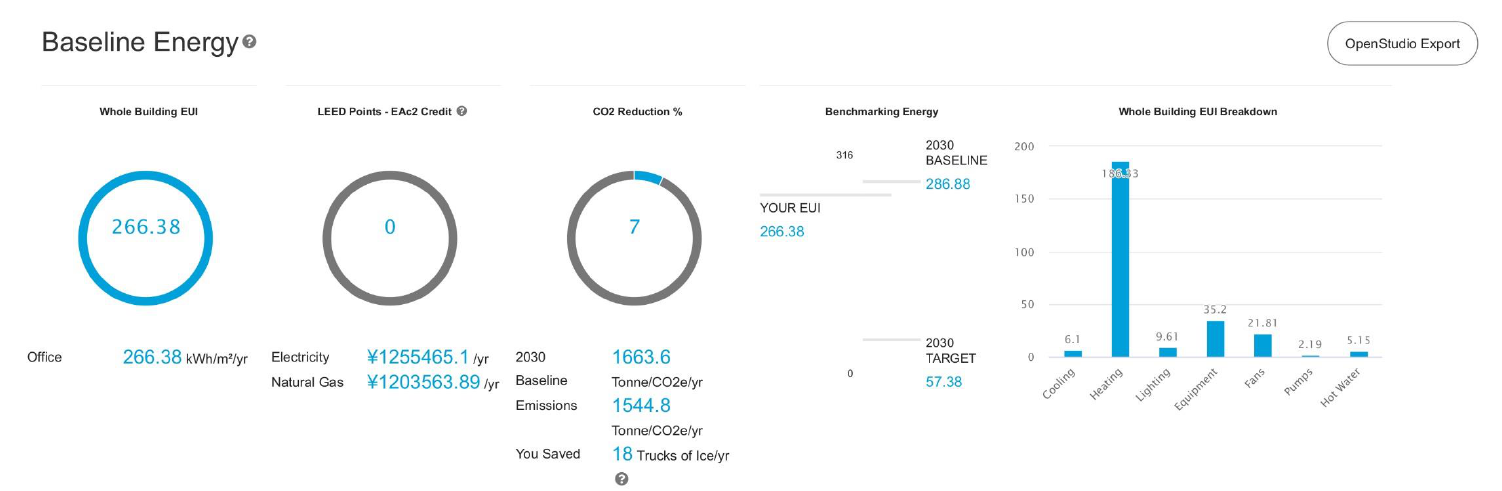
Figure A14. Zone 4-A Xi’an, Shaanxi (post-COVID-19 78% Figure A14. Zone 4- A Xi’an, Shaanxi (post-COVID-19 78% scenario).